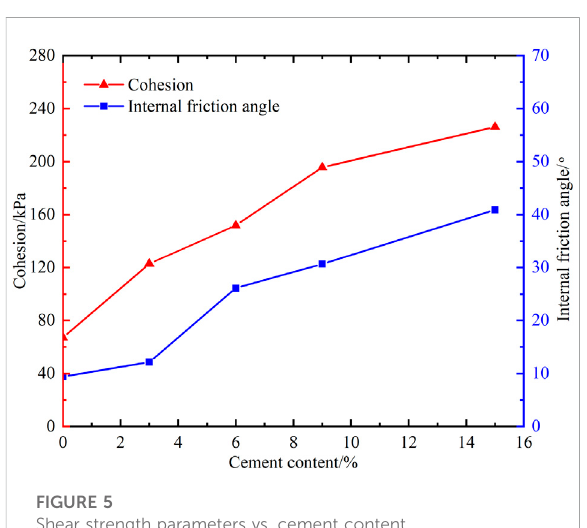
FIGURE 5 Shear strength parameters vs. cement